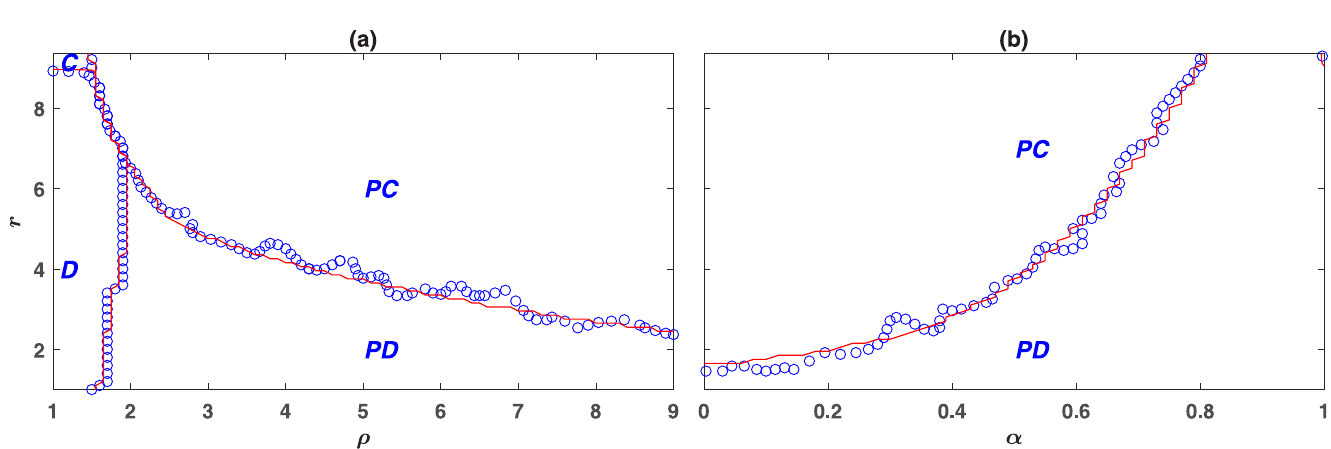
Fig 5. The phase diagram of non-wasteful punishment model for a mixed population. Blue circles denote the results of a simulation in a population of size N = 40000, and the red lines denote the results of the replicator dynamics. Depending on the parameters of the model, the model shows four different phases separated by discontinuous transitions. C , D , PC , and PD denote different phases in which, respectively, non-punishing cooperators, non-punishing defectors, punishing cooperators, and punishing defectors dominate the population. Here, g = 9, ν = 0.001, and c = c 0 = 1.